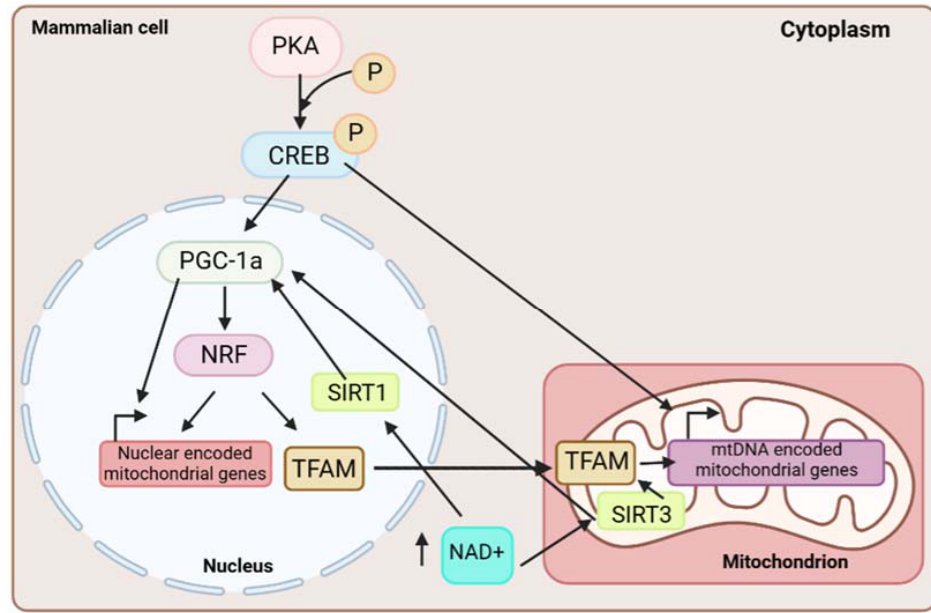
Figure 1. Mitochondrial biogenesis signaling pathway in mammalian cells. In the cytoplasm, PKA phosphorylates and, consequently, activates CREB, which then localizes to the mitochondria and starts the transcription of several mtDNA-encoded mitochondrial genes. Moreover, activated CREB translocates to the nucleus, where it causes the activation of PGC-1 α , which, on the one hand, activates the transcription of nuclear-encoded mitochondrial genes and, on the other hand, activates the NRF transcription factor family. NRF factors induce the transcription of nuclear ‐ encoded mito ‐ chondrial genes, including TFAM, a factor necessary for the transcription of mtDNA. Finally, in increased NAD+ level conditions, SIRT1/SIRT3 deacetylases are activated and provoke the deacety ‐ lation and activation of PGC ‐ 1 α and the aforementioned signaling pathway. Moreover, SIRT3 causes the deacetylation of TFAM to promote mitochondrial biogenesis.